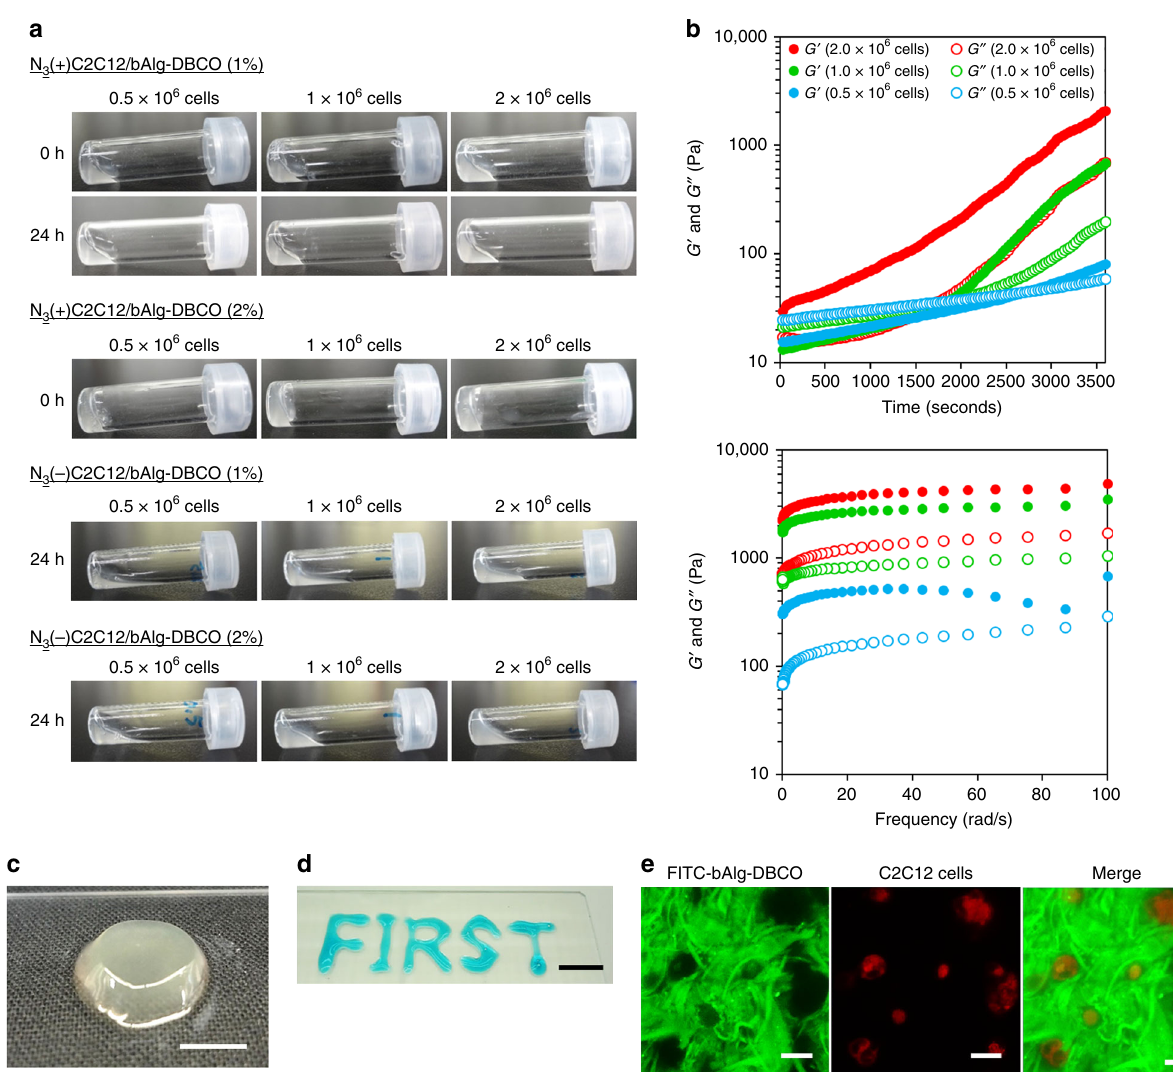
Fig. 2 Preparation and characterization of cell cross-linked hydrogels (CxGels). a Photographs of reaction mixtures of azide-modi fi ed C2C12 cells (0.5 × 10 6 , 1.0 × 10 6 , and 2.0 × 10 6 cells) and bAlg-DBCO solutions (1% and 2%, w/v) at 0 h and 24 h after the reaction. Photographs of dispersions of C2C12 cells (0.5 × 10 6 , 1.0 × 10 6 , and 2.0 × 10 6 cells) and bAlg-DBCO solutions (1% and 2%, w/v) after 24 h. b (upper) Gelation kinetics determined through oscillatory time sweep of CxGels prepared from bAlg-DBCO (2%) and azide-modi fi ed C2C12 (0.5 × 10 6 , 1.0 × 10 6 , and 2.0 × 10 6 ) at 37 °C under constant strain (5%) and frequency (10 rad/s). The crossover time point of the storage modulus ( G ′ ) and the loss modulus ( G ″ ) curves is de fi ned as the mechanical gel point. (lower) Frequency sweep of CxGels prepared from bAlg-DBCO (2%) and azide-modi fi ed C2C12 (0.5 × 10 6 , 1.0 × 10 6 , and 2.0 × 10 6 ) at 2 h after the start of the cross-link reactions at 37 °C under constant strain (5%). c Photographs of CxGels prepared through click reaction between azide-modi fi ed C2C12 cells (2.0 × 10 6 cells) and bAlg-DBCO solution (2%). Scale bar indicates 5 mm. d Photographs of the word FIRST written in CxGel made through click reaction between azide-modi fi ed C2C12 cells (2.0 × 10 6 cells) and bAlg-DBCO solution (2%). CxGels were stained with Fast Green FCF to aid visualization. Scale bar indicates 10 mm. e CLSM images of CxGels made through click reaction between azide-modi fi ed C2C12 cells (2.0 × 10 6 cells) and bAlg-DBCO solution (2%). Green: FITC-bAlg-DBCO, red: azide-modi fi ed C2C12 cells stained with CytoTell Red. Scale bars indicate 20 μ